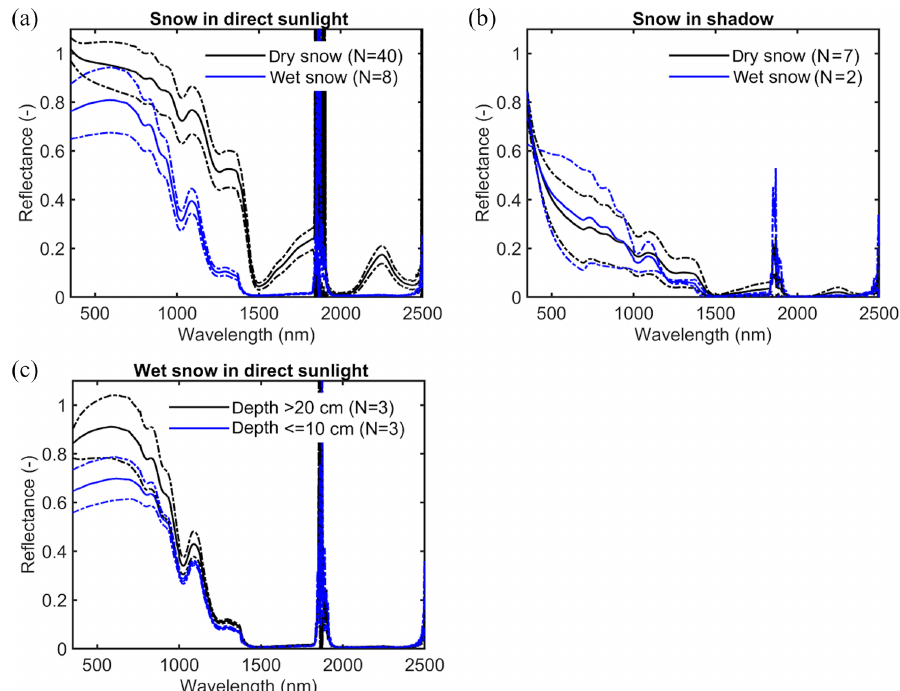
Figure 8. Field reflectance measurements of snow. Cloudiness for all measurements was less than 3 octas. Dry snow (a–b) and wet snow (a– c) correspond to class 1 and classes 3–4 (wet and very wet snow) according to Fierz et al. (2009), respectively. Figures display the mean reflectance (solid line) and standard deviation (dashed line).